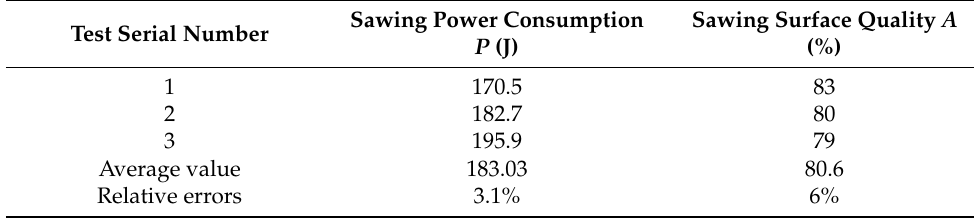
Table 6. Analysis of variance for sawing surface quality score values.